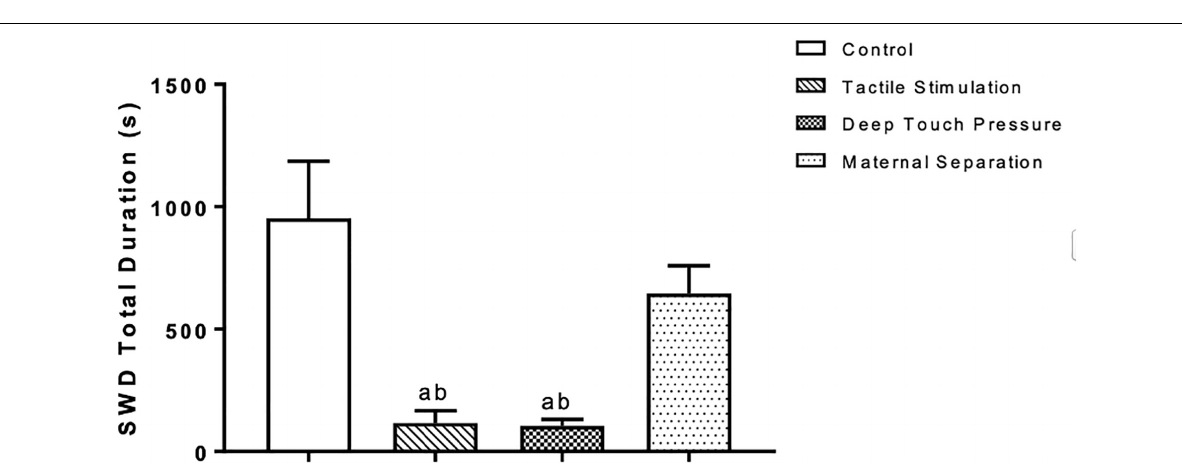
FIGURE 8 | Mean and SEM ( n = 8 per group) of the total duration of SWD was less in TS and DTP groups compared to control ( a p < 0.005) and MS ( b p < 0.05) groups at the four-hour recording period (one-way